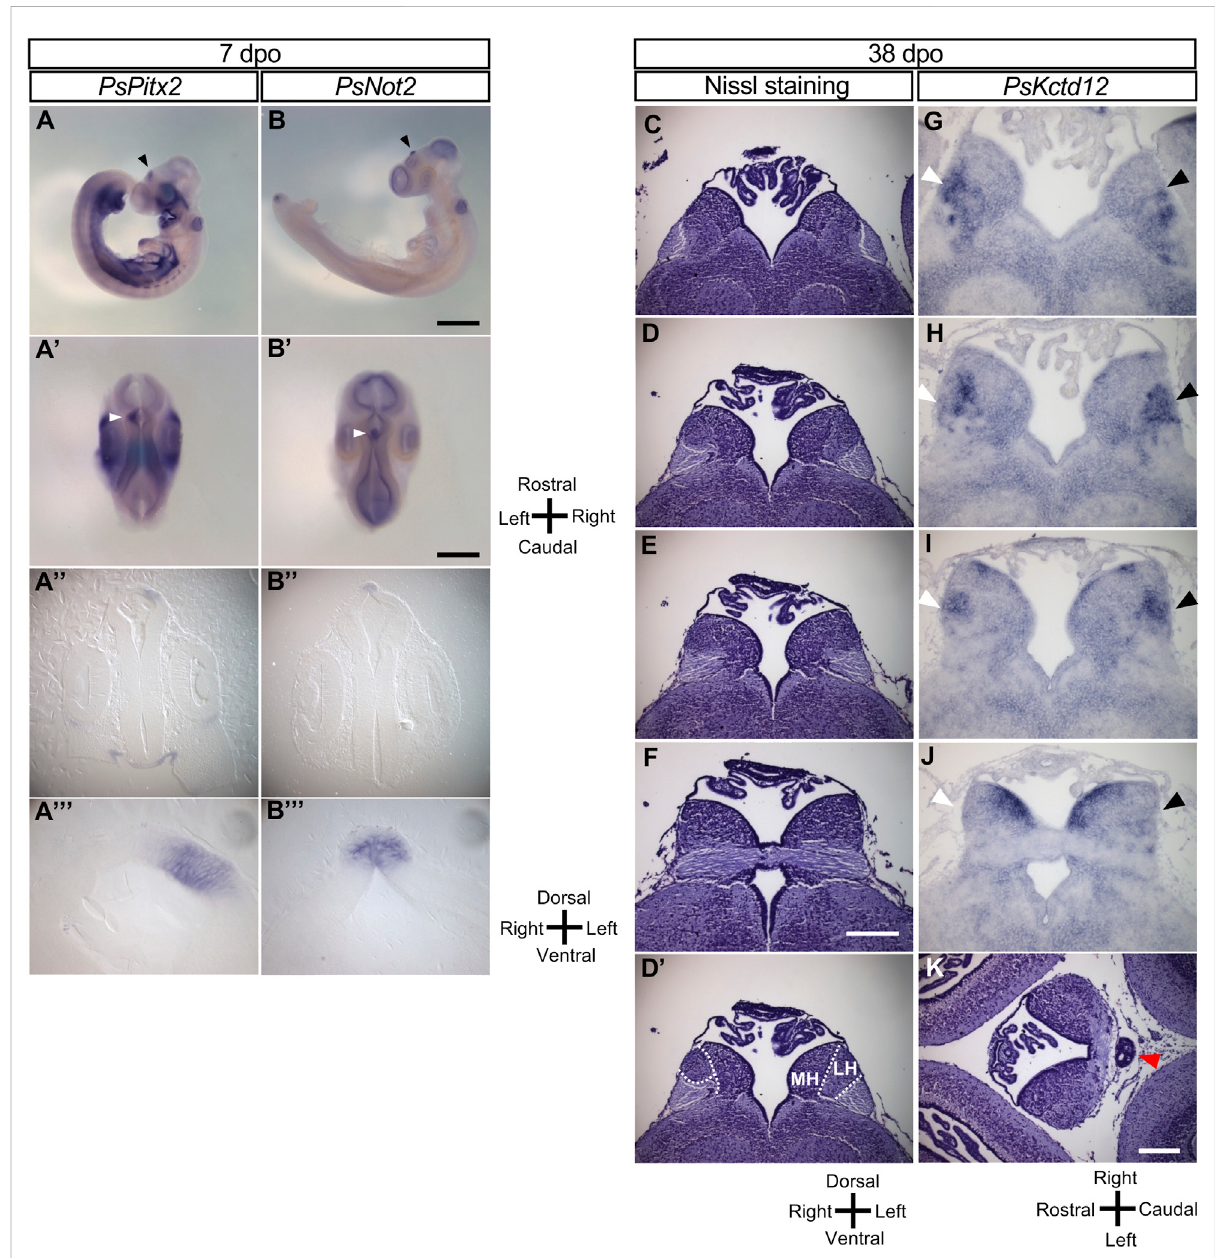
FIGURE 2 Molecular and morphologicalL-Rasymmetry ofthediencephaloninChinesesoftshellturtle embryosatlaterstages. (A,B) Whole-mount insitu hybridization analysis of Pitx2 (A) and Not2 (B) in the developing brain of embryos at 7 dpo. Left lateral views (A,B), dorsal views (A,B) , frontal sections (A,B) , and higher magni fi cation views of the frontal sections (A,B) are shown for each embryo. Closed arrowheads indicate the regions showing L-R asymmetricexpressioninthedevelopingbrain.Scalebars,1.0 mm(toppanels)and0.5 mm(secondfromthetoppanels). (C – F) Nisslstainingof frontal sections of embryos at 38 dpo. Sections at the level of the habenula are shown from the rostral side (C) to the caudal side (F) . There was no apparent L-R asymmetry in morphology although a subtle asymmetry may exist in (D) . Dotted lines in 2 (D) indicate subdivision of the habenula shown in (D) . MHand LHdenote themedial habenula andlateralhabenula,respectively. Scale bar, 0.2 mm. (G – J) Kctd12 expression inthehabenula as examined by in situ hybridization with frontal sections of embryos at 38 dpo. Frontal sectional levels in (G – J) are similar to those in (C – F) , respectively. Regions positive for Kctd12 expression on the right and left sides are indicated by white and black arrowheads, respectively. (K) Nissl- stained section of a Chinese softshell turtle at 38 dpo. The pineal organ is marked by the red